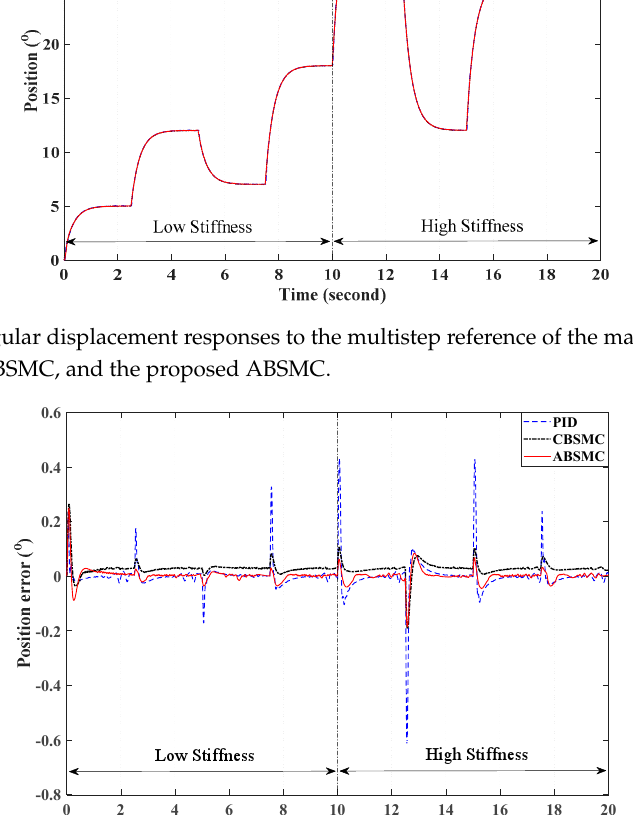
Table 1. Performance Indexes. .